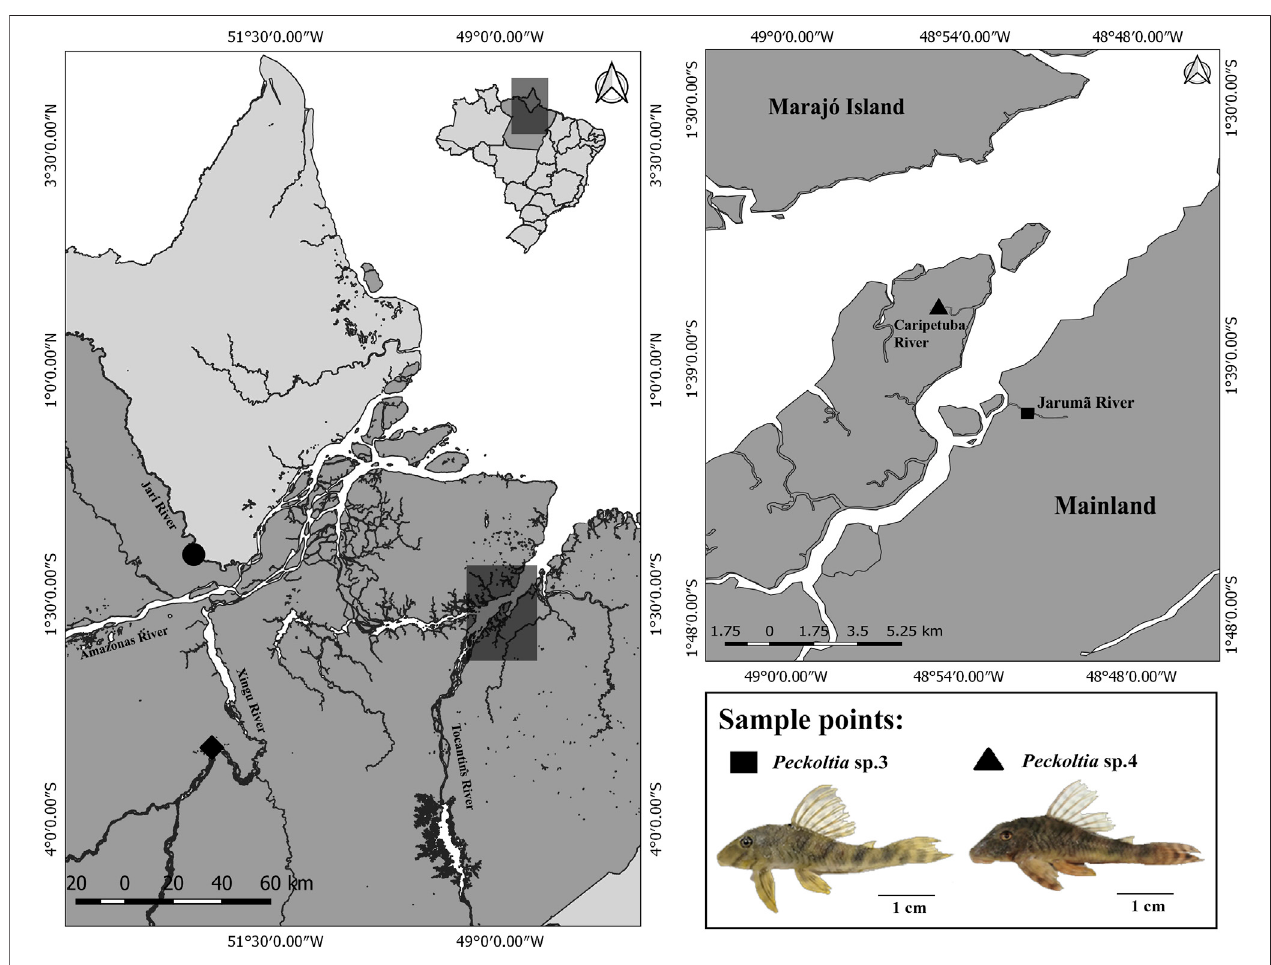
FIGURE 1 | Geographical location of sampling sites for Peckoltia sp. 3 Jarumã (square) and Peckoltia sp. 4 Caripetuba (triangle) in the present study. The coordinates of the sampling sites for Peckoltia vittata (diamond), Peckoltia sp. 1, and Peckoltia sp. 2 (circle) reported by de Souza et al. (2009) are also shown. The map was made using QUANTUM-GIS (Q-GIS) v. 3.4.5. The database was obtained from Instituto Brasileiro de Geogra fi a e Estatística — IBGE. An Peckoltia specimen is shown below. Scale bar: 1 cm. Photo by